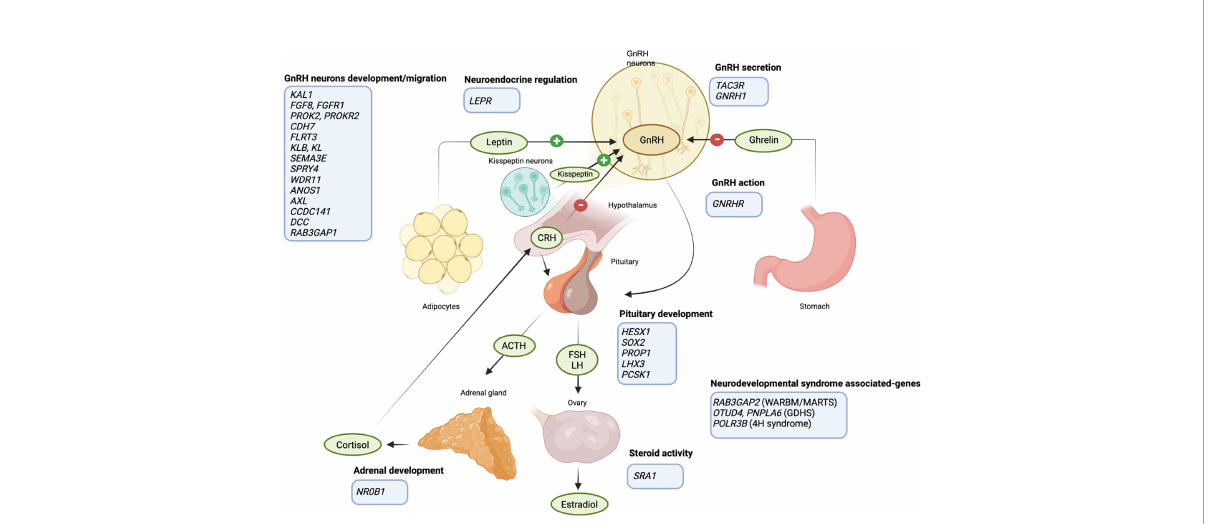
FIGURE 1 Schematic representation of the HPG axis regulation and the FHA predisposing genes. GnRH neurons in the hypothalamus release GnRH upon different stimuli: kisspeptin, produced by a speci fi c group of hypothalamic neurons, is a major player in the neuroendocrine control of GnRH and gonadotrophins secretion; ghrelin and leptin allow the regulation of GnRH secretion according to energy balance (link between HPG axis and food intake); cortisol inhibits GnRH secretion (link between HPG axis and anxiety). FHA-predisposing genes are listed in the light blue boxes (created with BioRender.com).